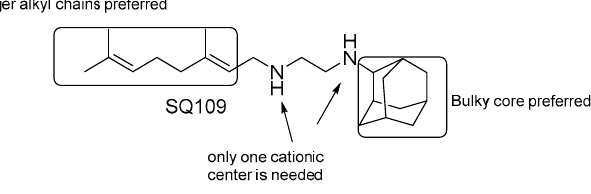
Figure 21. SAR analysis of SQ109.